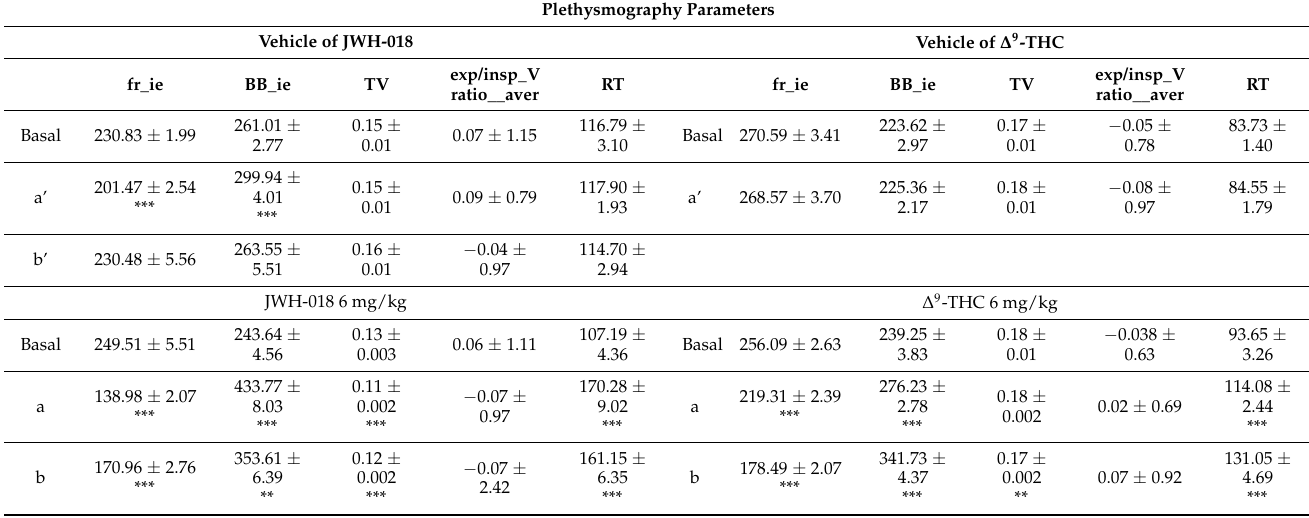
Table 2. Effect of systemic administration of vehicle (a’, b’), JWH-018 6 mg/kg (a and b) and ∆ 9 -THC 6 mg/kg on respiratory electrical parameters (plethysmography analysis). Data are relative to BR dose-response curve (Figure 12A,B). Data are expressed as mean overall effects of 15 evaluations for baseline and after vehicle or JWH-018 treatment of 4 mice. Data are analyzed with iox2 software, and they are expressed as MEAN ± SEM of evaluations recorded in 1-min time window, capturing data with an acquisition frequency of 1000 Hz. Statistical analysis was performed by Student’s t -test for each basal and after treating parameter comparisons. ** p < 0.01, *** p < 0.001 vs. basal values. FR_IE (bpm; breathing frequency); BB_IE (ms; breath length computed by adding inspiration and expiration duration); TV (mL/s; tidal inspiration volume); EXP/INSP_V_RATIO__AVER (ratio